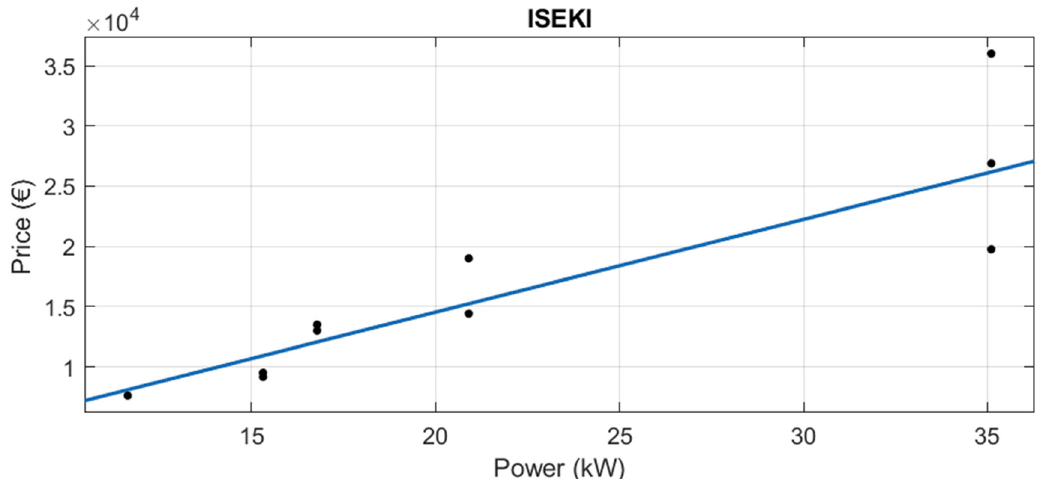
Figure 6. Price vs. power for Fendt new tractors.